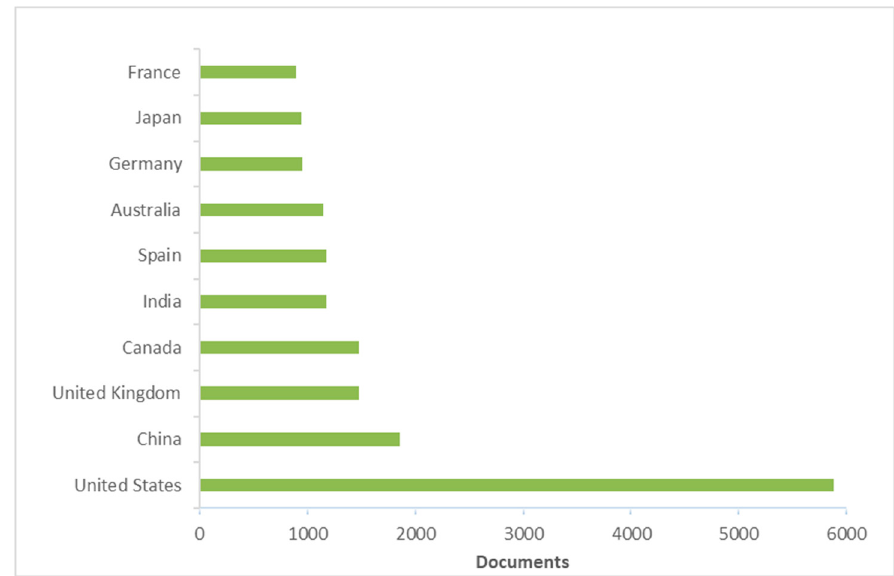
Figure 5. Most productive countries/territories. (Based on data from Scopus).